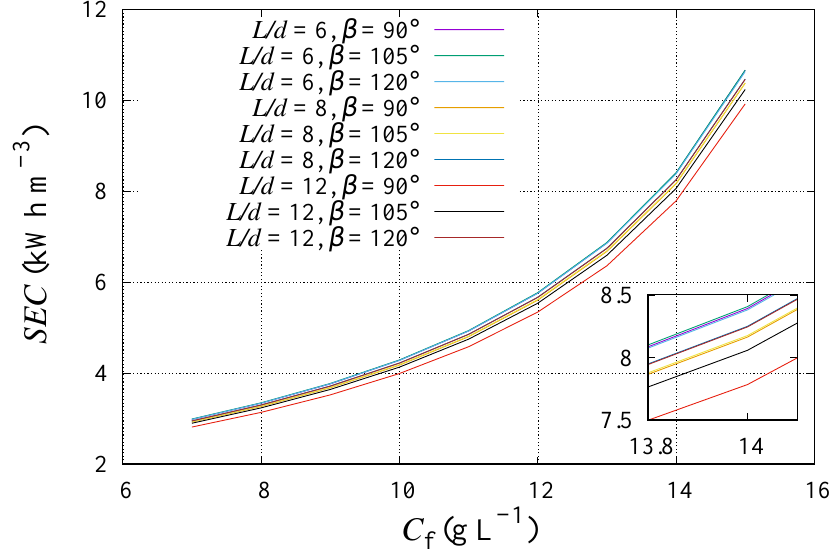
Figure 4. SEC of the membrane FILMTEC TM ECO PRO-400 considering different feed spacer geometries, a range of C f , p f = 15 bar and Q f = 11 m 3 h − 1